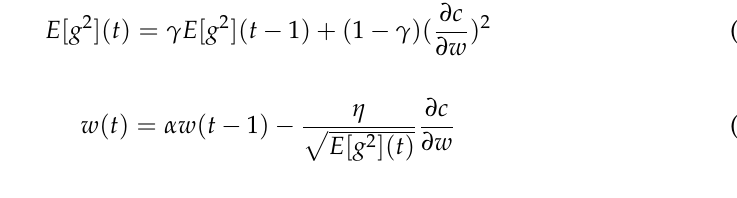
Table 4. Hyperparameters for the semantic segmentation